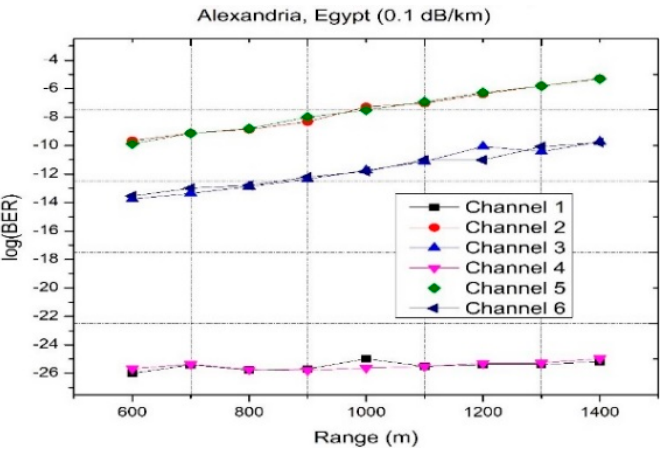
Figure 10. Log (BER) versus FSO link for Alexandria, Egypt.